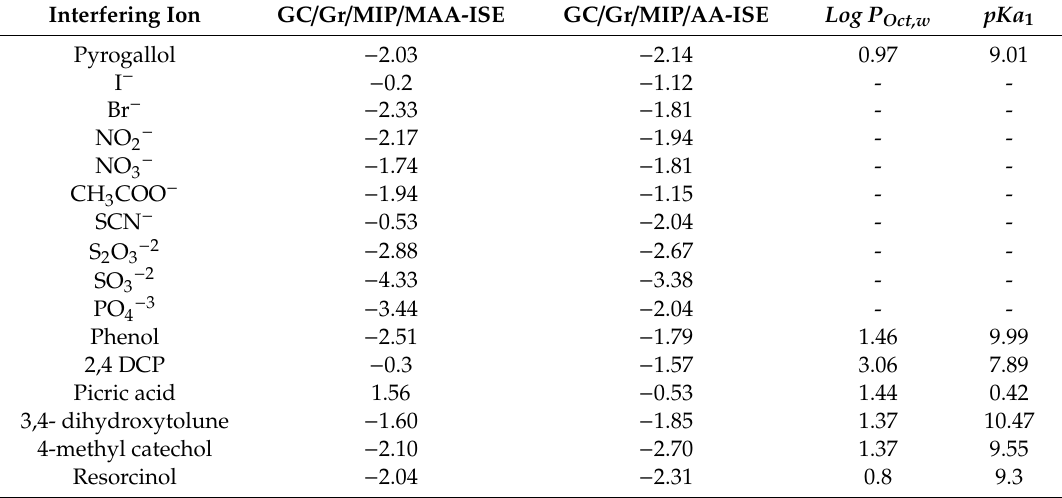
Table 2. Selectivity coe ffi cients ( K pot i,j ) using separate solution methods in 30 mM PBS at pH 7.